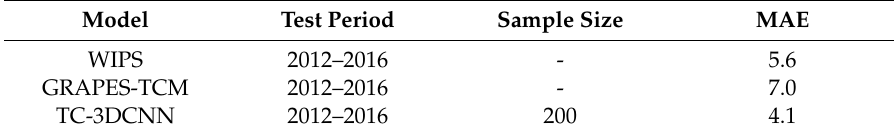
Table 4. Comparison with existing models in terms of the MAE (m / s) of TC intensity change prediction